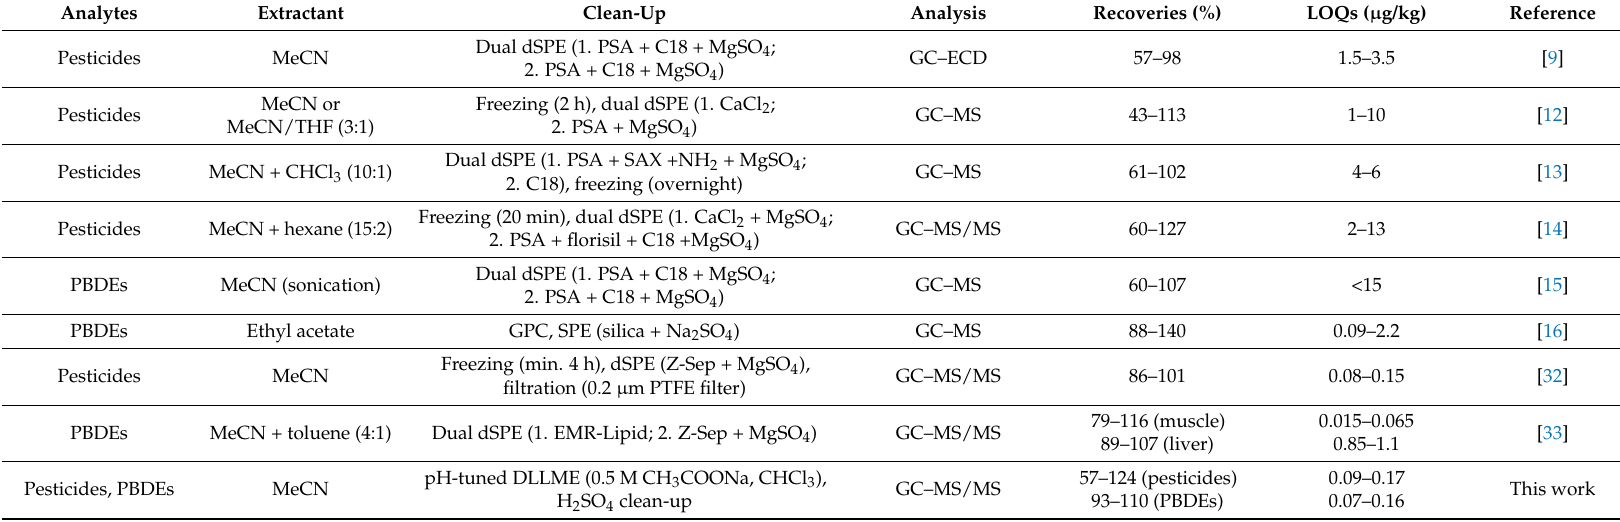
Table 9. Comparison of the developed method with other QuEChERS based methods with enhanced sample extract clean-up for determination of test analytes in fish.